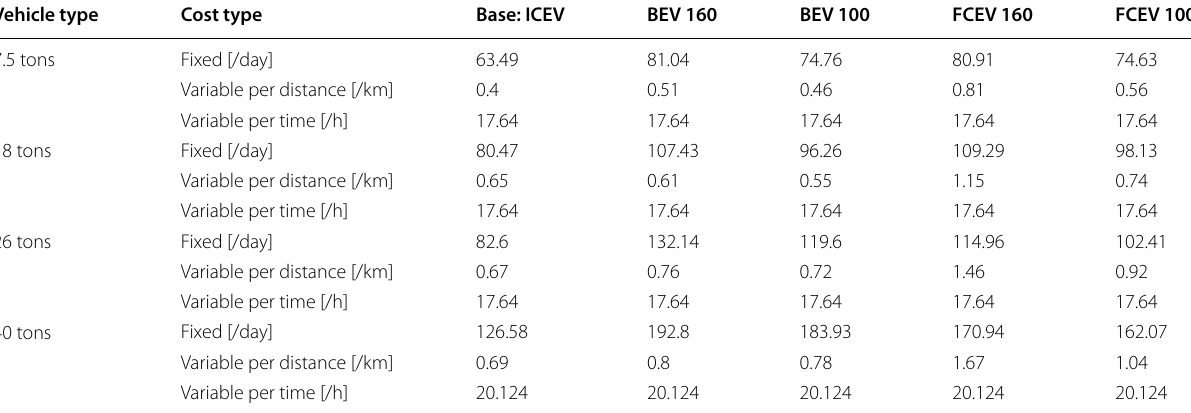
Table 2 Cost parameters for vehicle